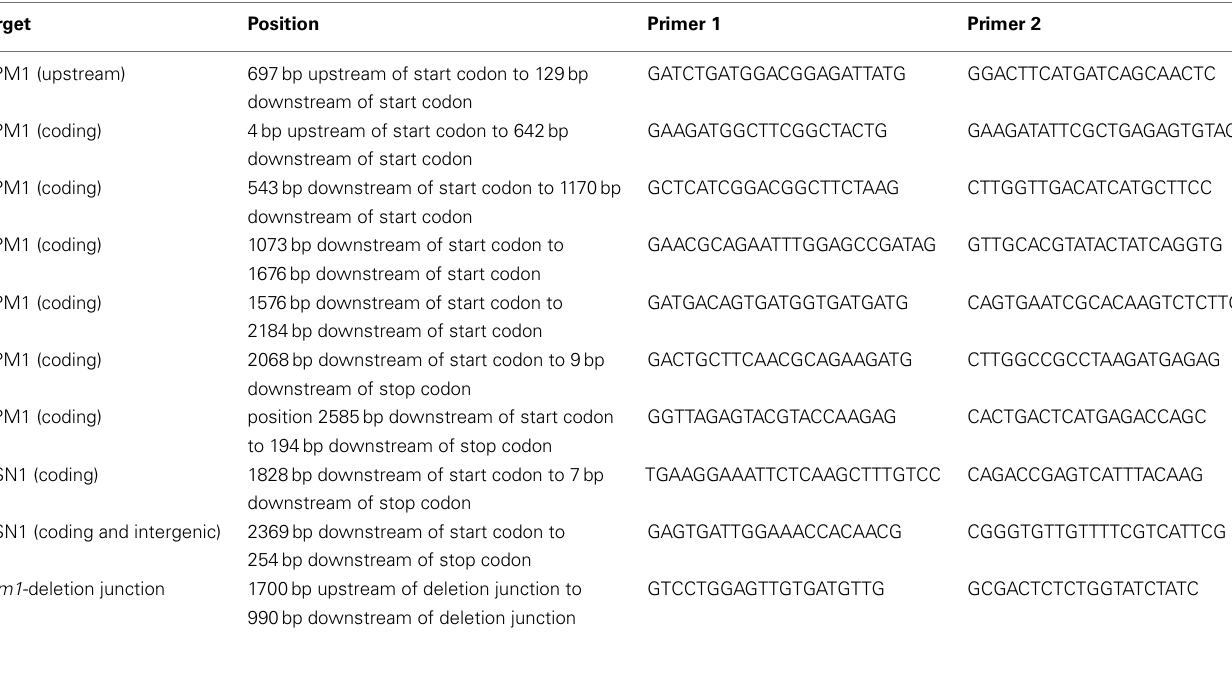
Table 3 | Sequences and annealing positions of primers used in this